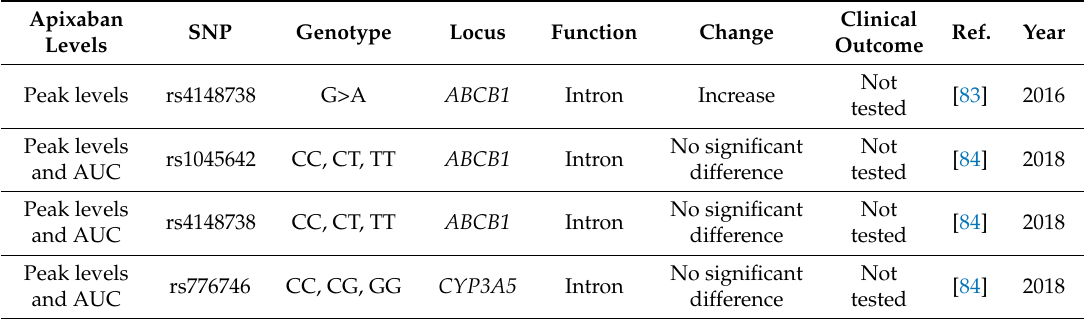
Table 4. Common genetic variants associated with variation in pharmacokinetics and pharmacodynamics of